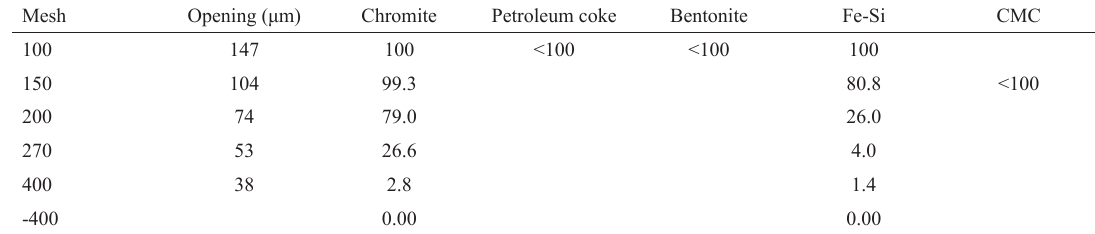
Table 3: Particle size of the materials (wt%) Mesh